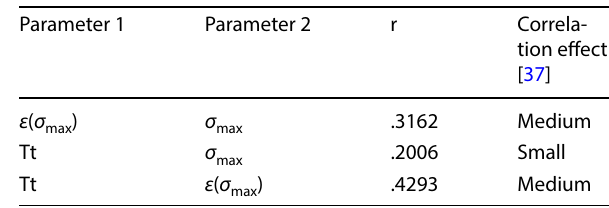
), elongation at maximum tensile max